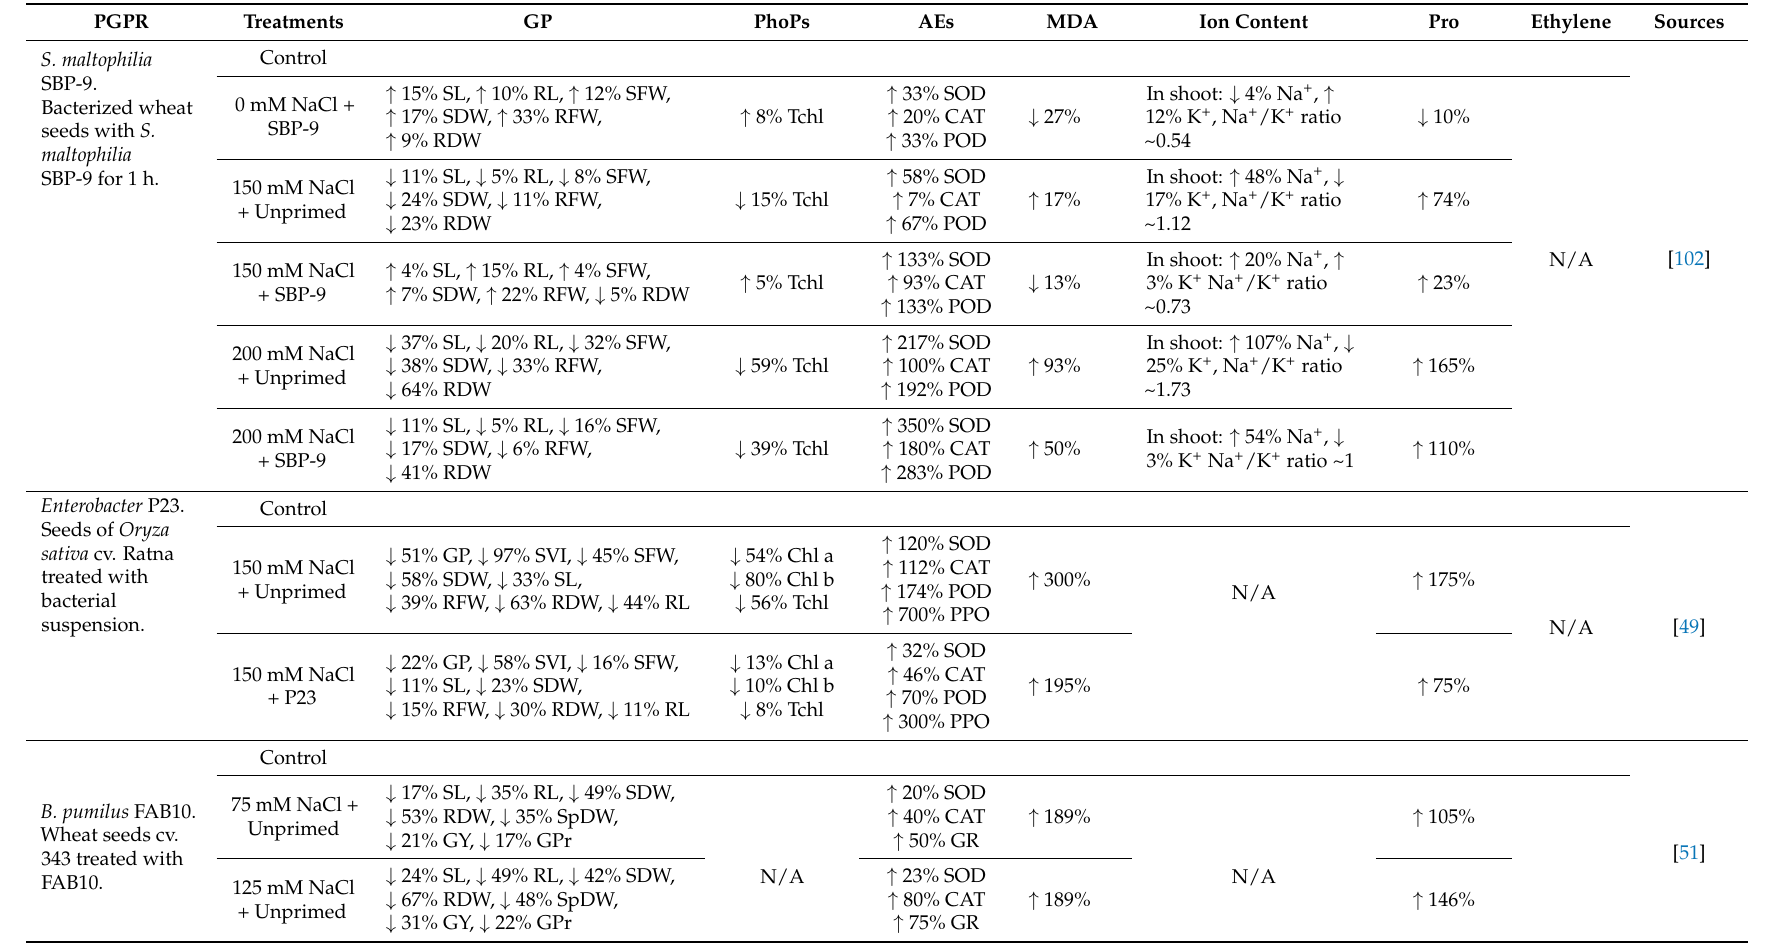
Table 2. The use of PGPR in seed biopriming technique for improving salinity stress tolerance in plants.